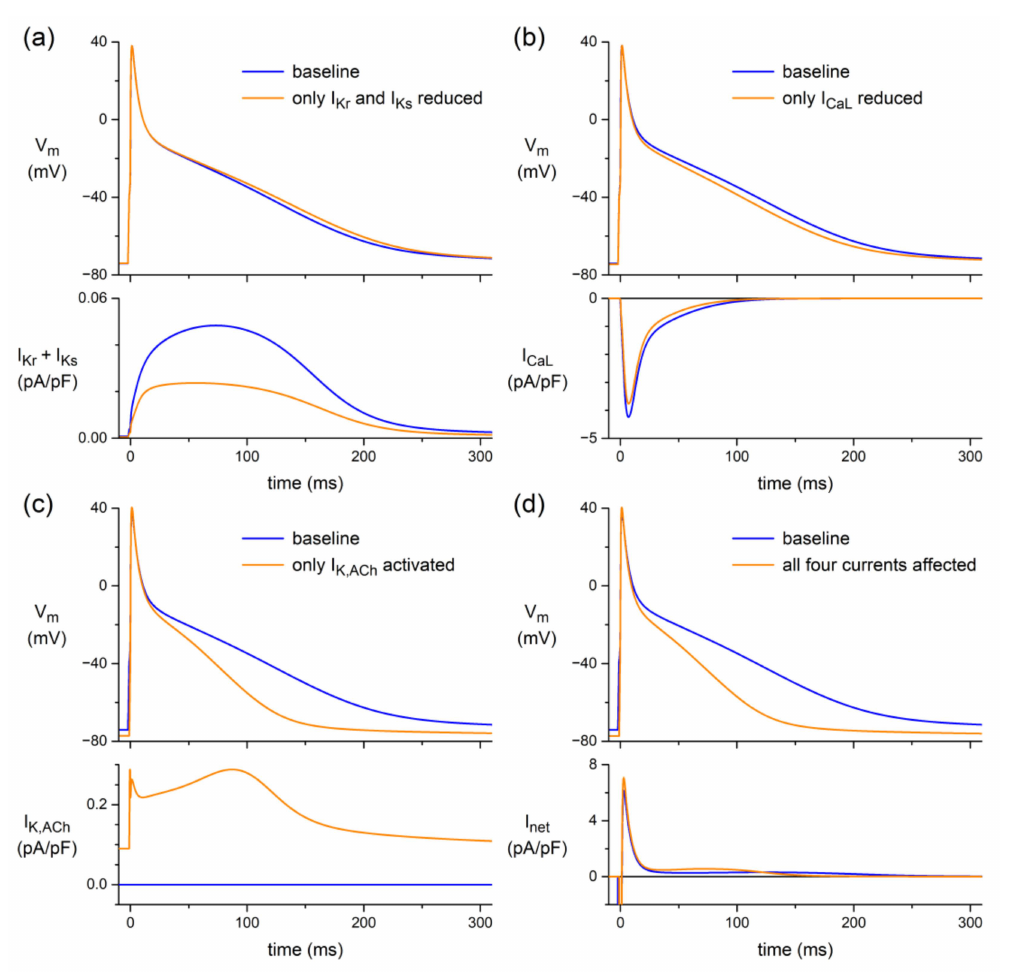
Figure 6. Effects of ACh-induced changes in the L-type Ca 2+ current (I CaL ), the rapid and slow delayed rectifier K + currents (I Kr and I Ks , respectively), and the ACh-activated K + current (I K,ACh ) on the electrical activity of the Maleckar et al. human atrial cell model [45] at 1 Hz. ( a ) Membrane potential (V m ; top) and associated outward current carried by I Kr and I Ks (I Kr + I Ks ; bottom) if ACh affects only I Kr and I Ks . ( b ) V m (top) and associated inward current carried by I CaL (bottom) if ACh affects only I CaL . ( c ) V m (top) and associated ACh-activated K + current (I K,ACh ; bottom) if ACh affects only I K,ACh . ( d ) V m (top) and associated net membrane current (I net ; bottom) if ACh affects all four currents, i.e., I CaL , I Kr , I Ks , and I K,ACh . Note differences in current